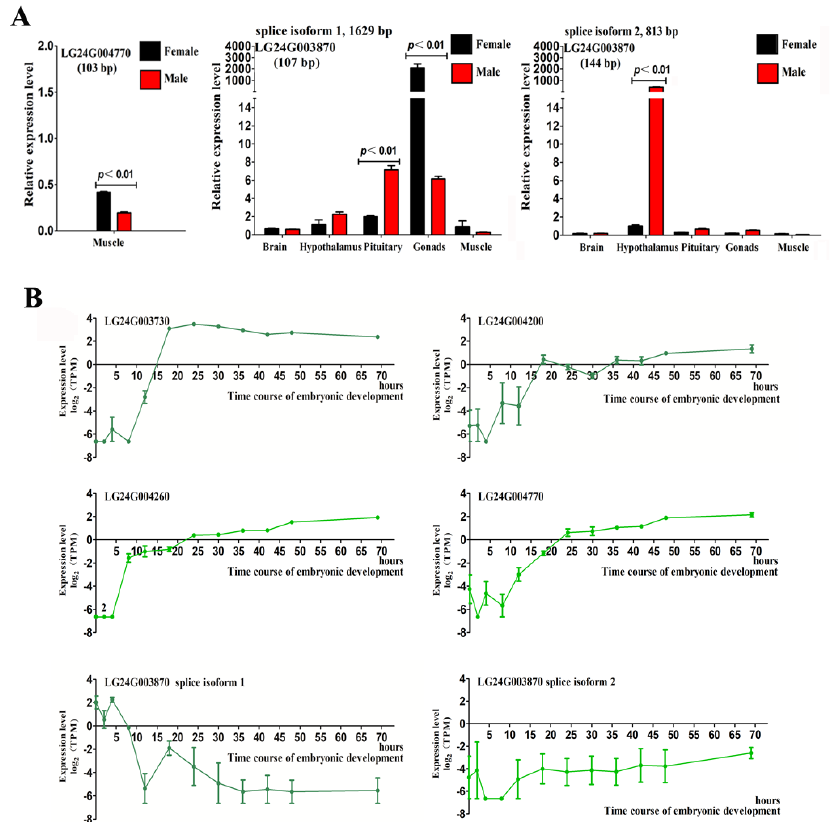
Figure 4. Quantitative polymerase chain reaction (PCR) detection of gonadal differentially expressed genes and transcriptional analysis during embryonic development. ( A ) Quantitative PCR detection of LG24G004770 and LG24G003870 in differentially expressed tissues. The values 103, 107, and 144 bp represent the amplification length. The abscissa represents different tissues, and the ordinate represents the relative expression. ( B ) Transcriptional expression of six transcripts of five genes (LG24G003730, LG24G004200, LG24G004260, LG24G004770, and LG24G003870) in early embryonic development. The abscissa represents the fertilization time, and the ordinate represents the expression level indicated by log 2 (transcript per million, TPM).